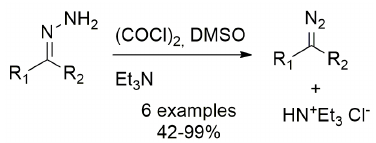
Figure 33- New route for dehydrogenation of hydrazones.